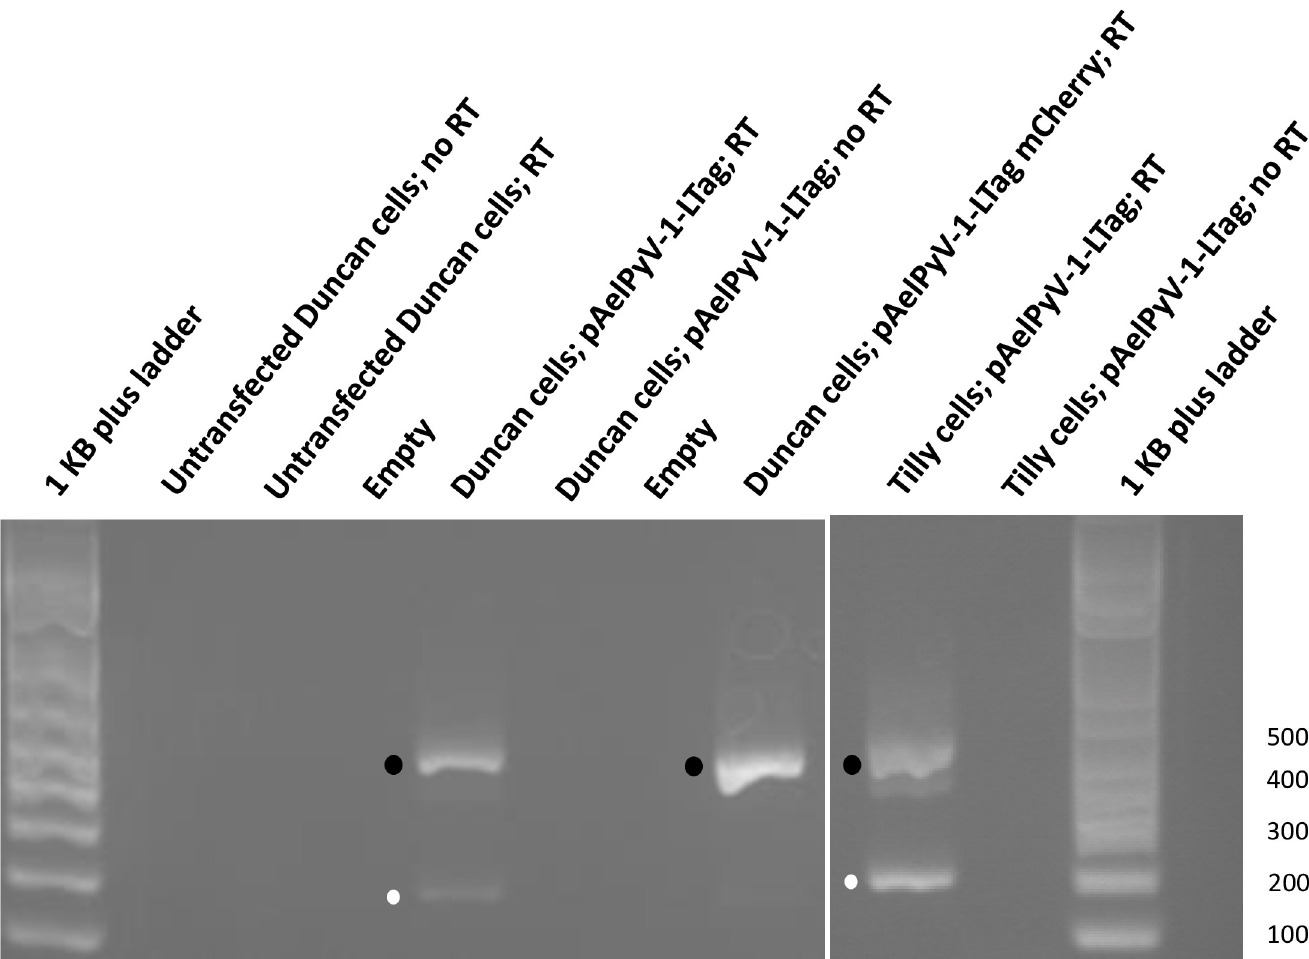
Fig 8. Verification of transcription of the LTag and STag antigens in transformed cells. The PAelPyV-1-Tag transfected cells expressed both LTag (expected 150– 250 bp; white dot) and STag (expected 400–500 bp; black dot). Cells transfected with PAelPyV-1-Tag+mCherry-LTag expressed only STag.